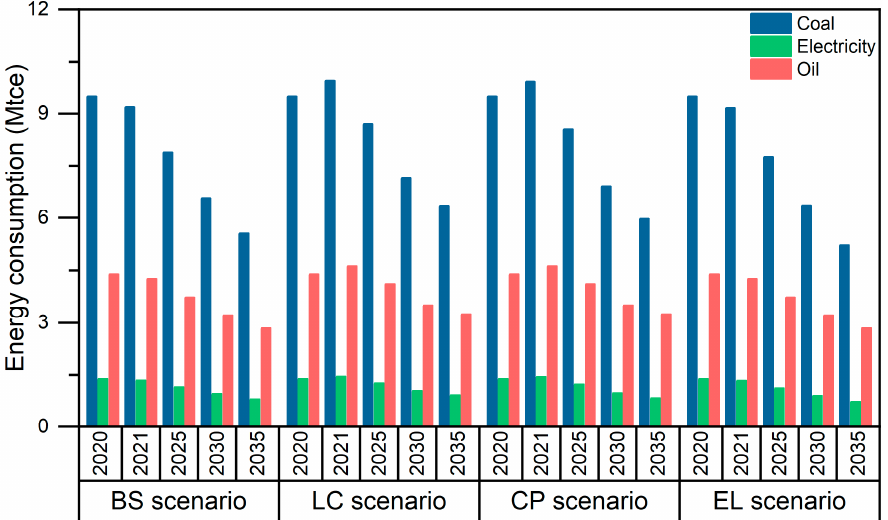
Figure 3. Energy consumption of cement industry in Shandong Province from 2020 to 2035.